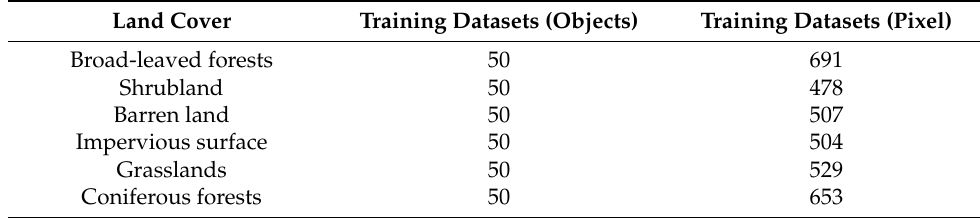
Table 3. Training Datasets and Validation Datasets.